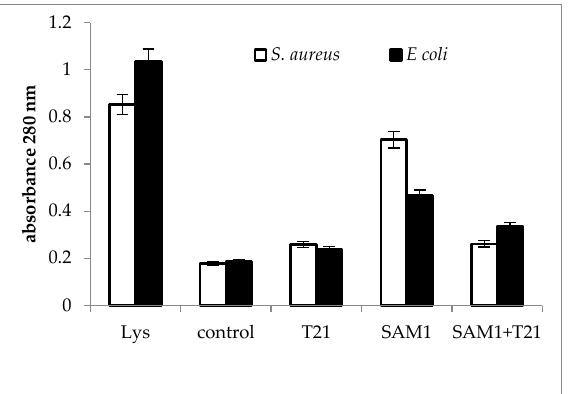
Figure 6. UV absorbance at 260 nm in S. aureus ATCC 33952 and E. coli ATCC 11229 cultures after treatment with T21, SAM1, and SAM1 + T21 (concentration of compounds and combinations: T21 0.5%; SAM1 1MIC; SAM1 1MIC + T21 0.5%).